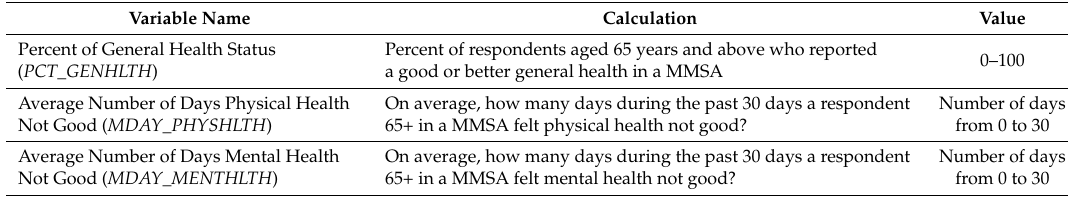
Table 2. MMSA-level measures for health-related quality of life derived by aggregation